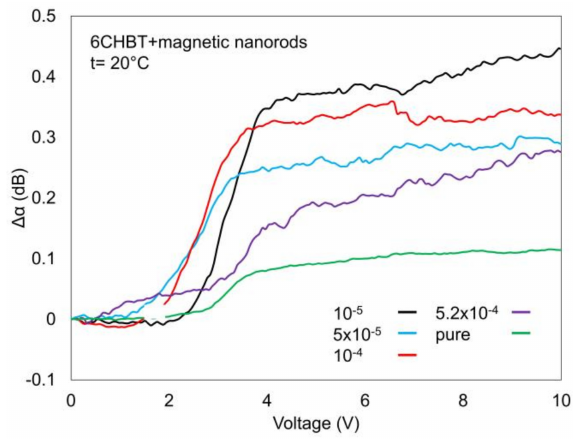
Figure 3. E ff ect of applied voltage on SAW attenuation for 6CHBT doped with magnetic nanorods of di ff erent concentrations.